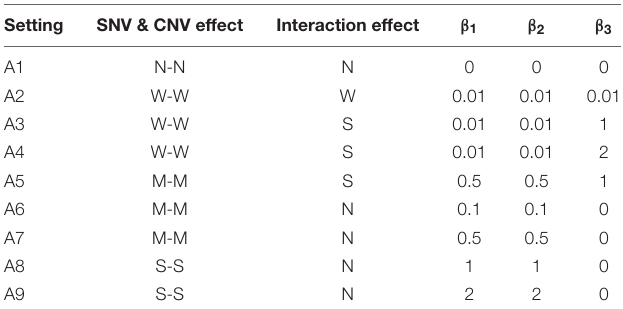
TABLE 1 | The twenty-one genes considered in the simulation studies. No.